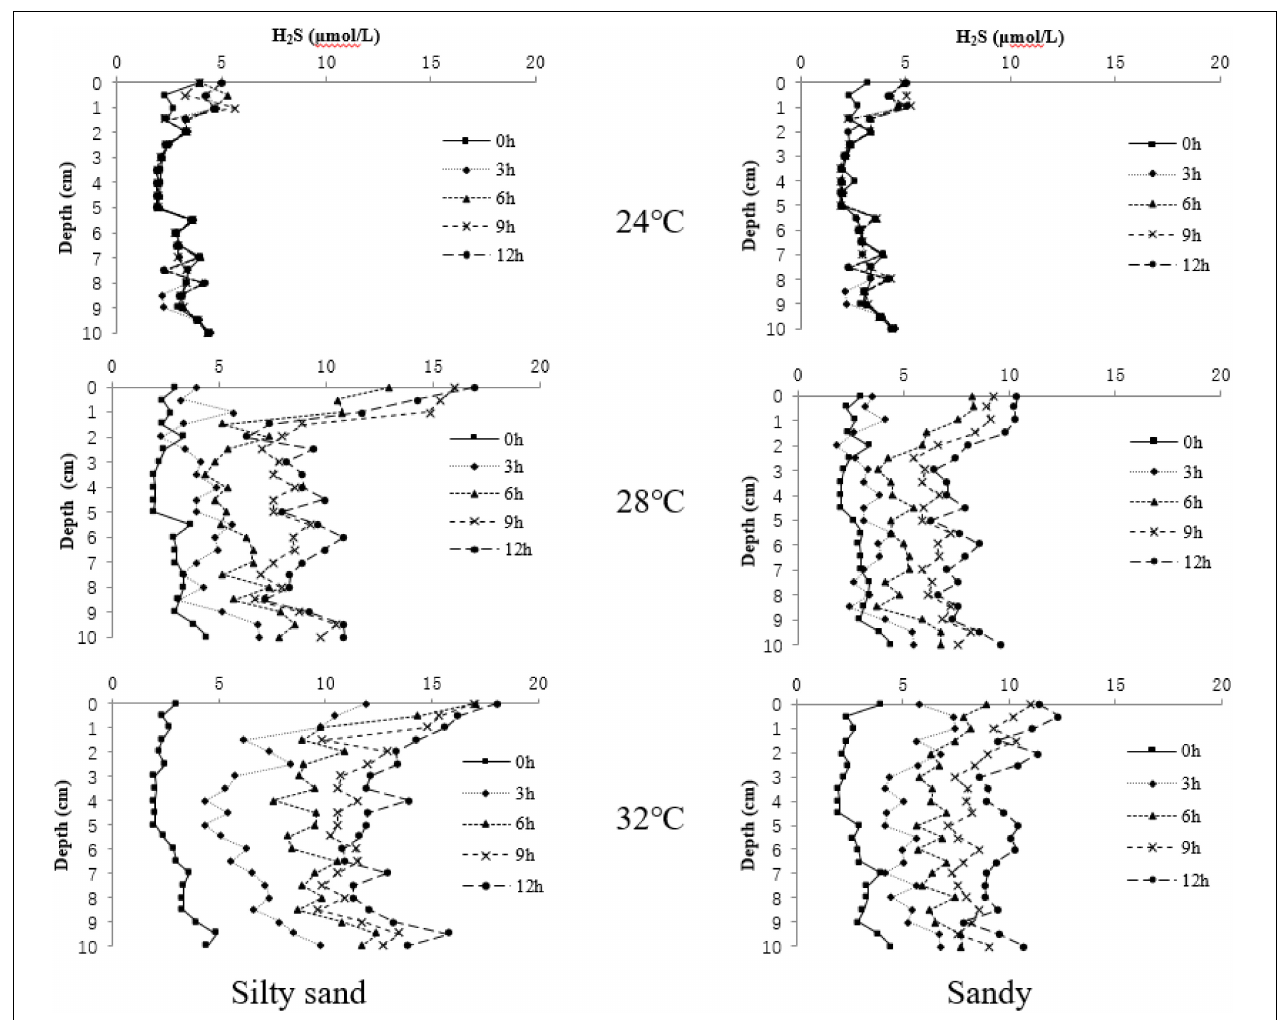
FIGURE 2 | H 2 S concentrations at different depths over time in two sediment substrate types.